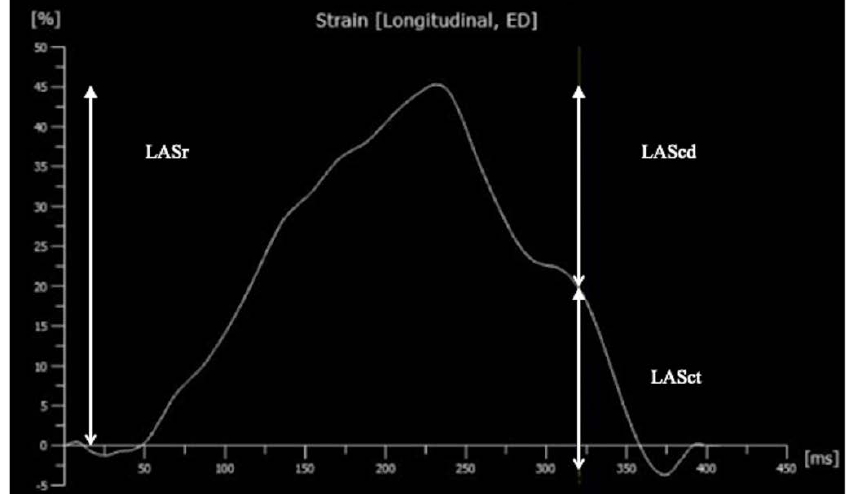
Figure 1. Longitudinal atrial deformation curve during the three phases of the left atrial with the zero strain reference at end-diastole. The respective strains are: LASr, strain during reservoir phase; LAScd, strain during conduit phase; and LASct, strain during contraction phase.